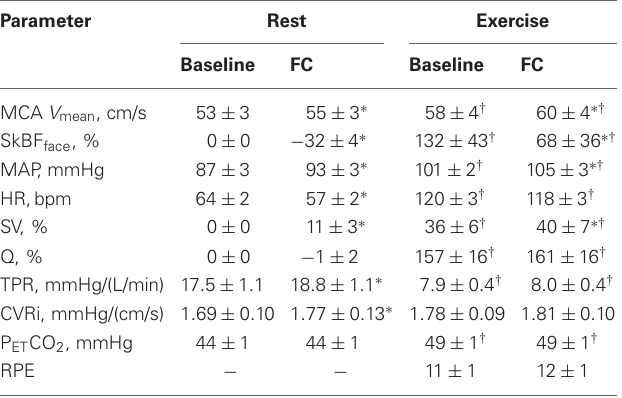
Table 2 | Hemodynamic and ventilatory responses and RPE. Parameter